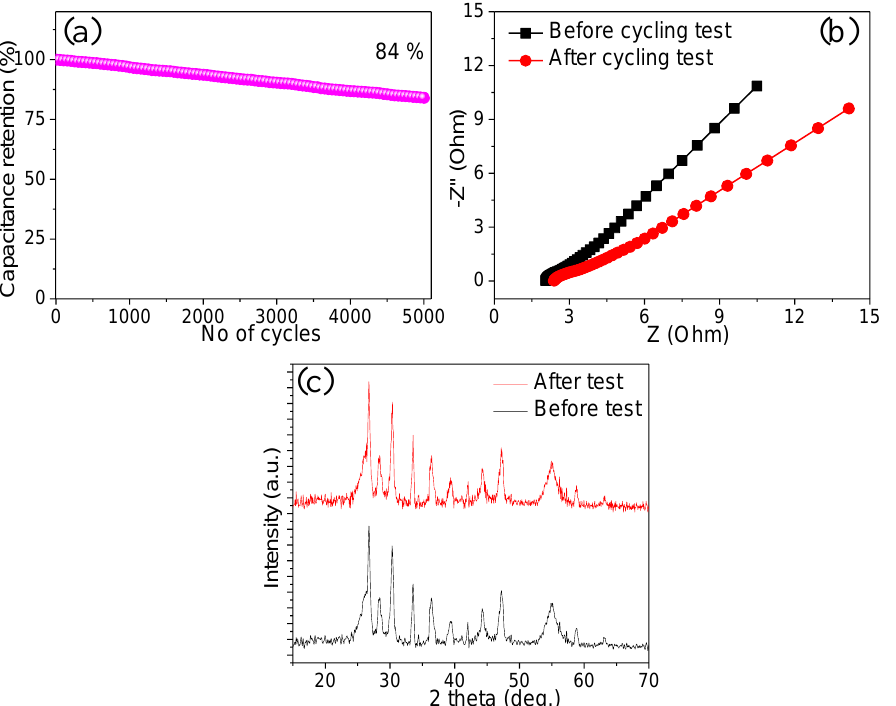
Figure 6. ( a ) Cycling stability test of ZnO@CC, ( b ) EIS spectra before and after cycling test, and ( c ) XRD patterns before and after stability tests.